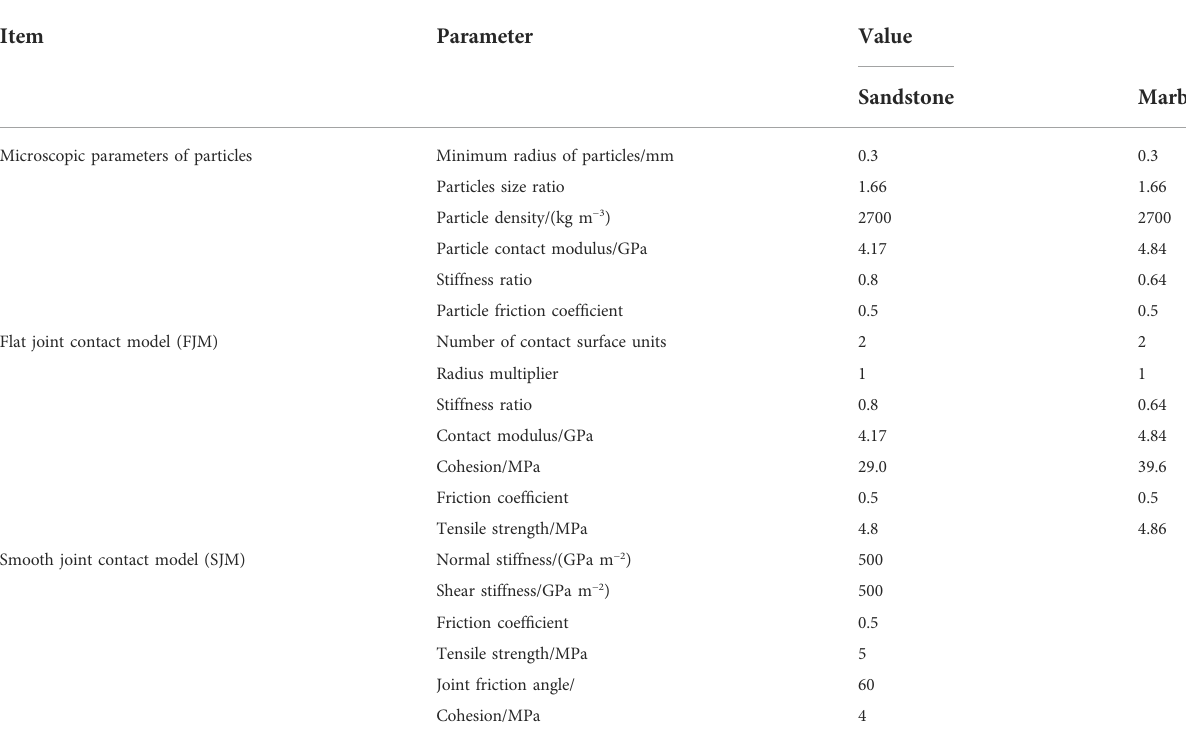
TABLE 6 Microscopic parameters of PFC 2D